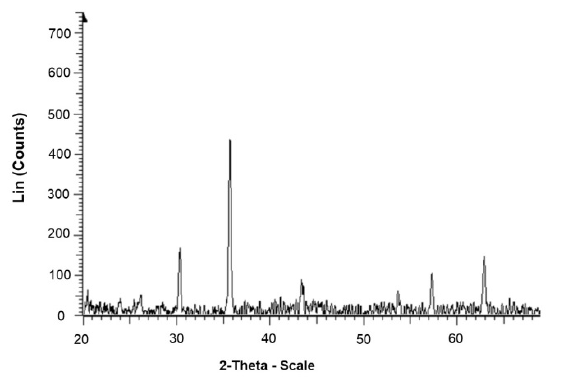
Figure 4. The XRD pattern of maghemite The results of experiments using real wastewater Samples of real wastewater were taken from local wastewater treatment plant. Initial concentration was 5 mg/L PO 43- . The optimum dosage of PVA was determined at 0.45 g beads in 50 mL or 0.005 g maghemite per 0.45 g PVA-M-beads in 50 mL were added.